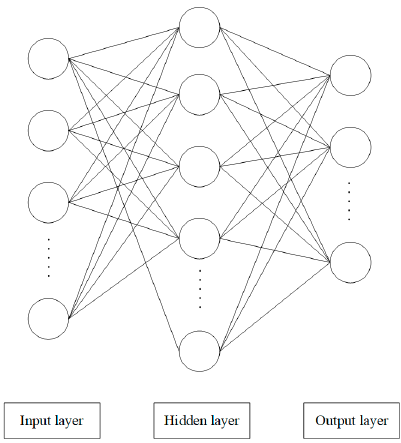
Figure 7. BPNN structure diagram.